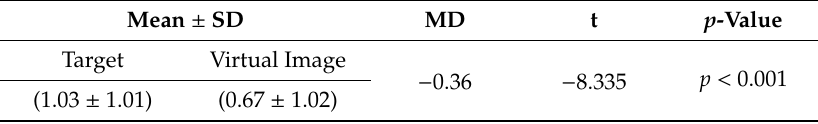
Table 2. Comparison of control reaction between 1.00 D and virtual image. Mean ± SD MD